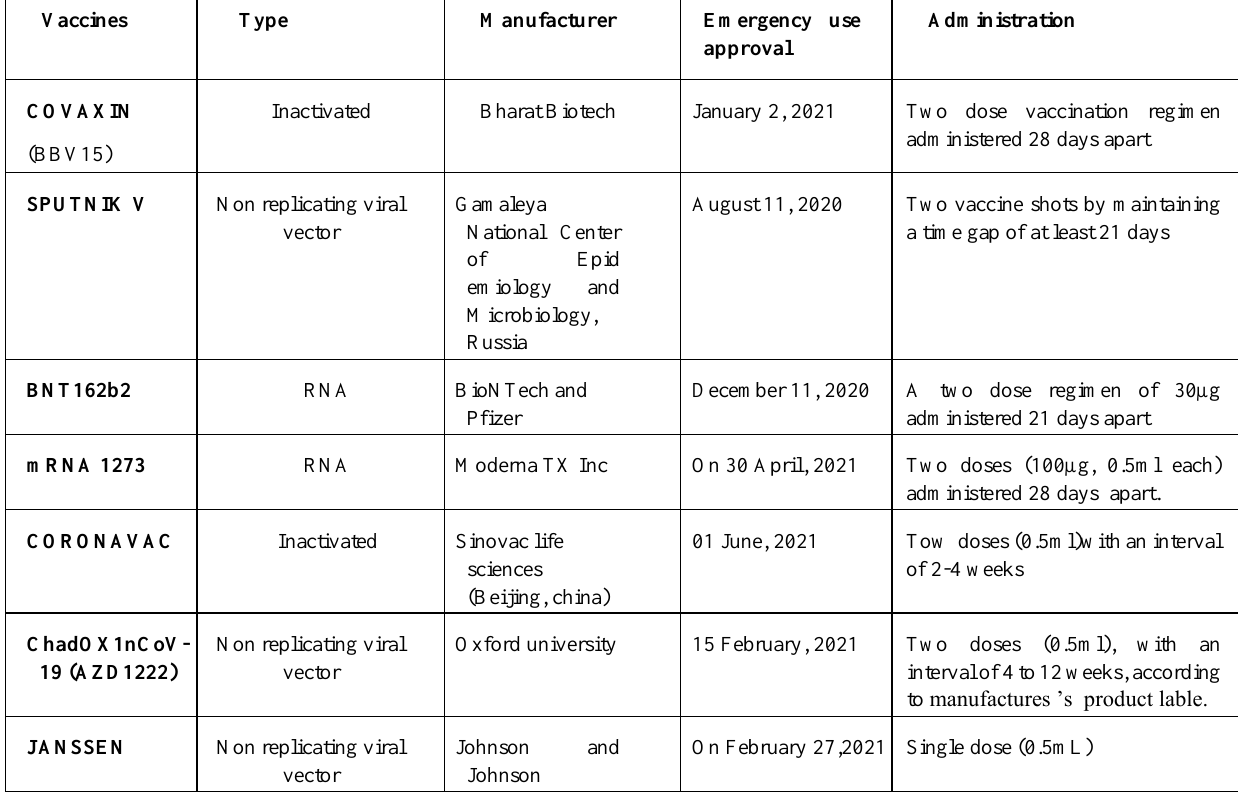
Table 1. Common vaccines against